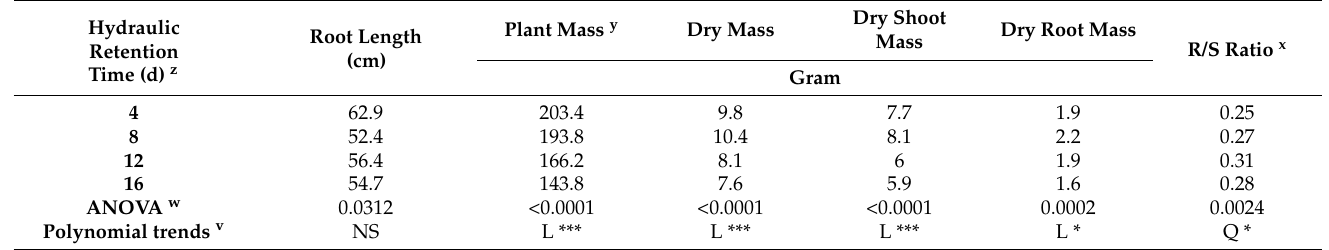
Table 2. Final plant measurement analysis of ‘Rex’ butterhead lettuce ( Lactuca sativa ) HRT without iron